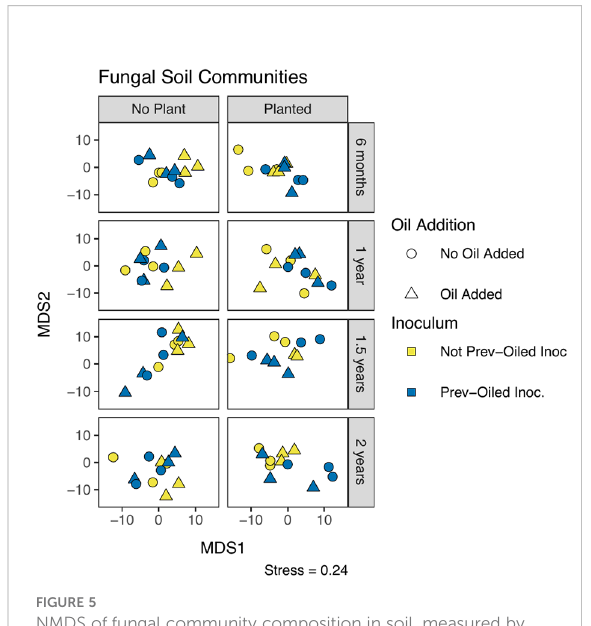
FIGURE 6 NMDS of fungal community composition in roots, measured by Aitchison distance. Each point represents a single replicate at a time point. Sampling points correspond to individual panels, chronologically from top to bottom. The oil addition treatment is represented by shape and the inoculum treatment by